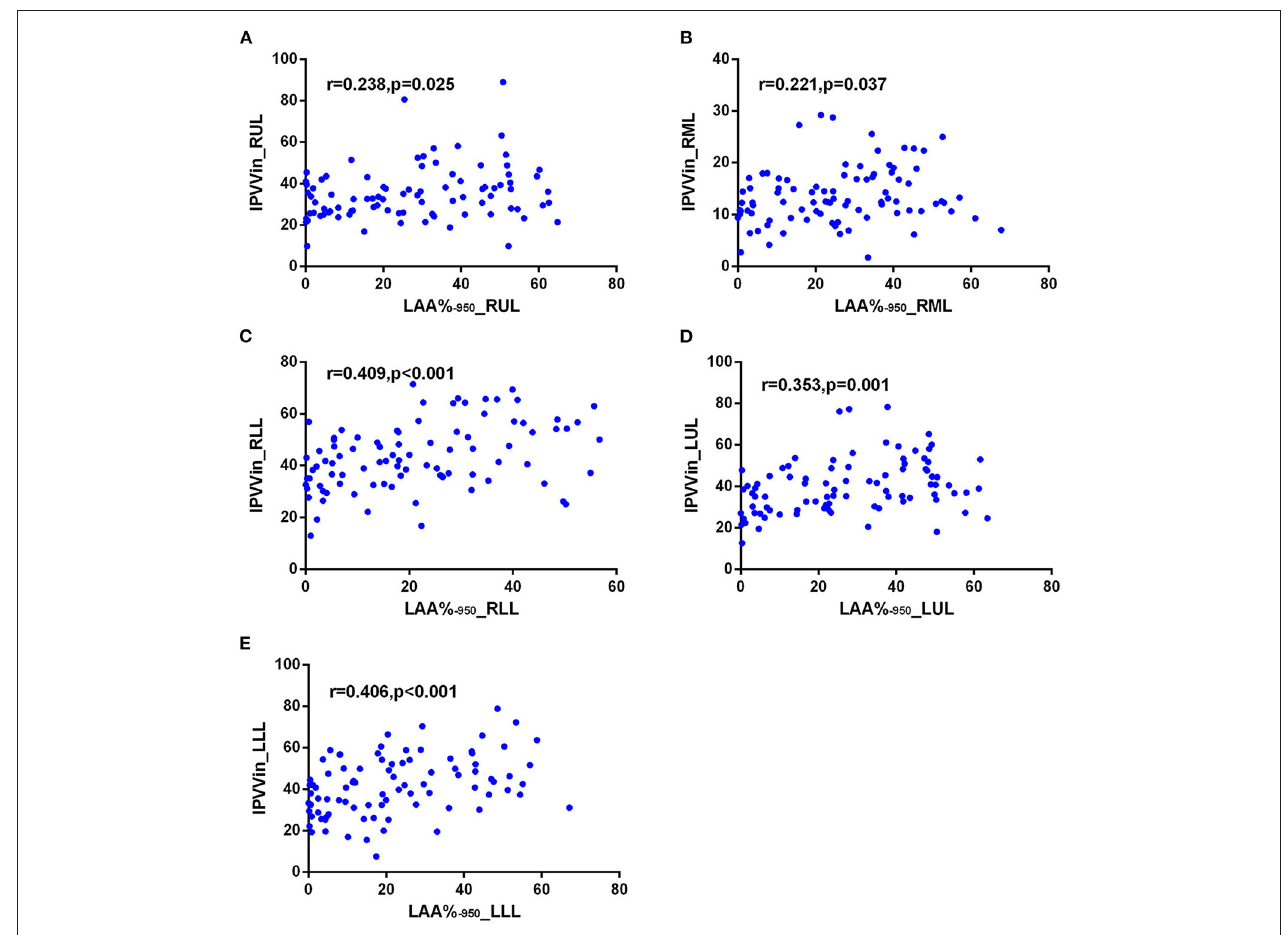
FIGURE 4 | Correlations of IPVV in individual lobes with LAA% − 950 in the inspiratory CT scan. (A) RUL; (B) RML; (C) RLL; (D) LUL; (E) LLL.